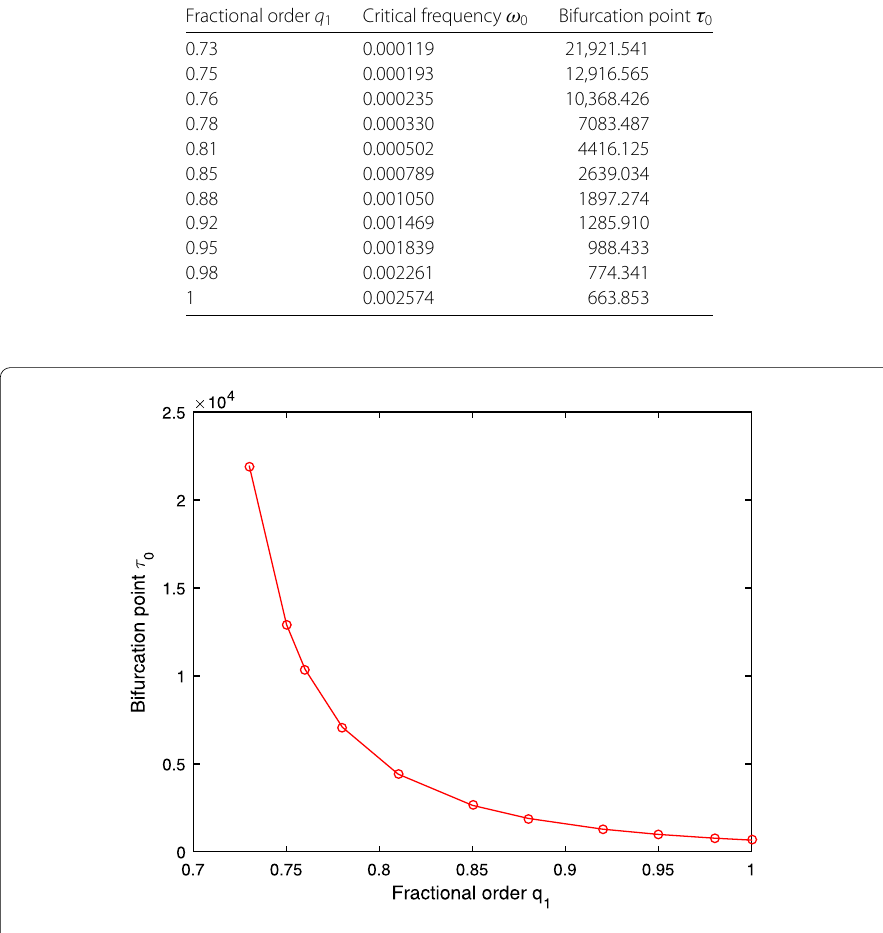
Figure 10 Graph of bifurcation point τ 0 versus the order q 1 for system (29) when q 2 is fixed at 0.95